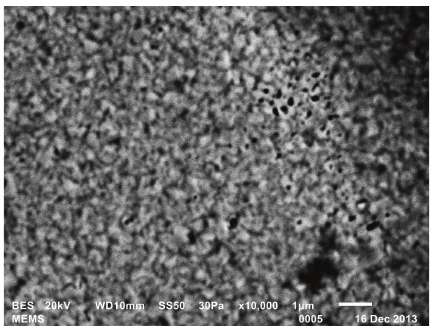
× 10000) collected around the point #1 on the contacting surface of the fixed base of DS switch (see Figure